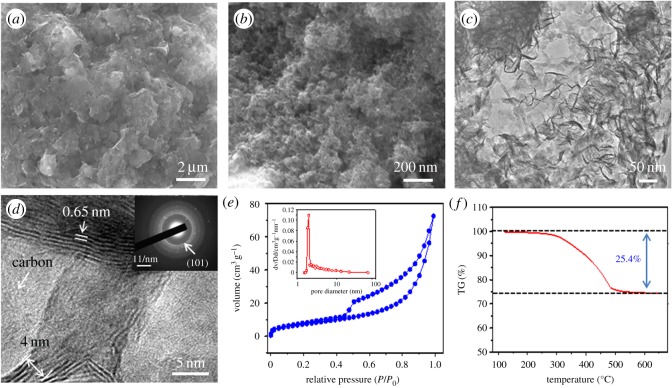
SEM images (a,b) and TEM images (c,d) of the MoO2/C nanosheets. N2 adsorption/desorption isotherms (e) and TGA results of the MoO2/C nanosheets (f).